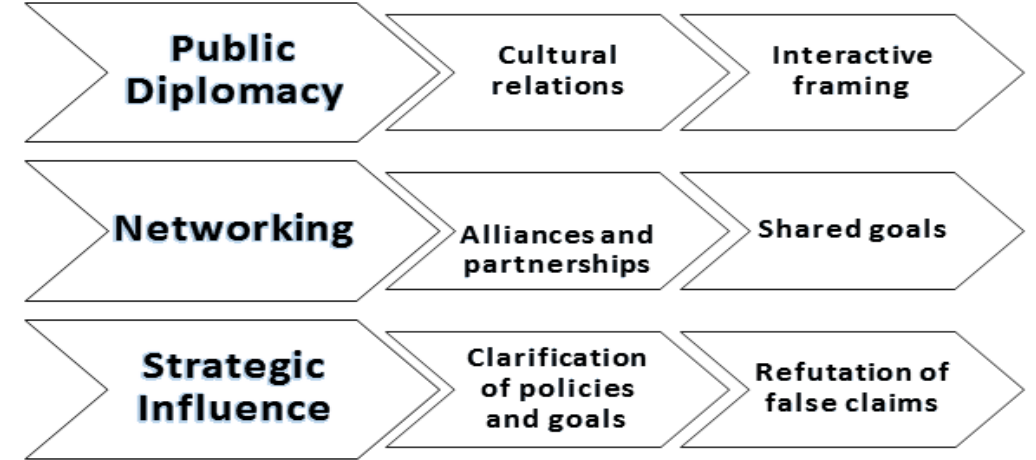
Figure 1 . Parallel paths of strategic influence and global